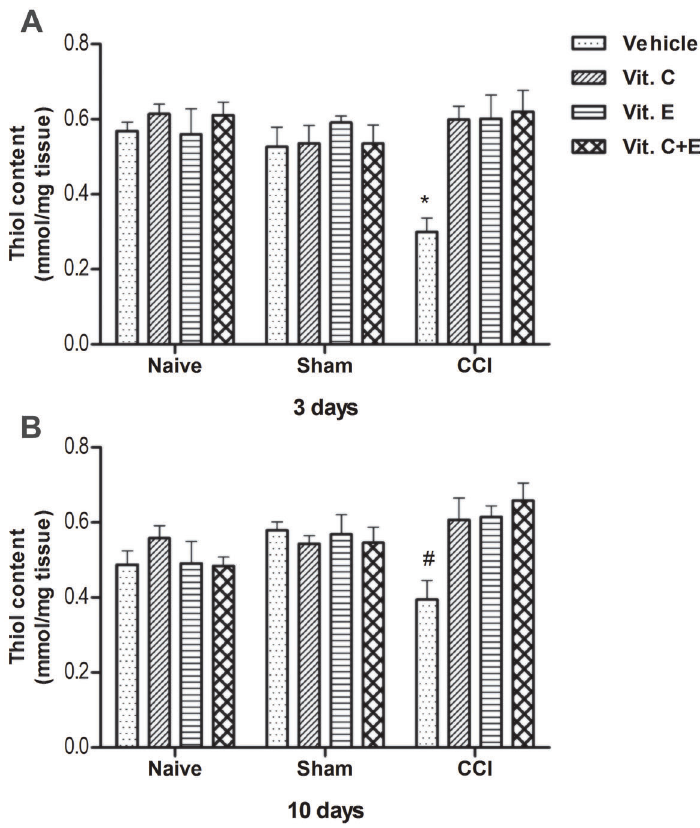
Figure 2. Total thiol content in the spinal cord of rats treated with vit. C (30 mg (cid:1) kg – 1 (cid:1) day – 1 ), vit. E (15 mg (cid:1) kg – 1 (cid:1) day – 1 ), a combination of these vitamins (vits. C + E) in the same doses, or the vehicle alone (saline containing 1% Tween 80) administered intraperitoneally for 3 ( A ) and 10 ( B ) days after chronic constriction injury (CCI). Data are reported as means ± SE (n=6/group). *P o 0.05 compared to naive and sham rats and vitamin-treated CCI rats over the same experi- mental period. # P o 0.05 compared to vitamin- treated CCI rats over the same experimental period (two-way ANOVA followed by Tukey post hoc